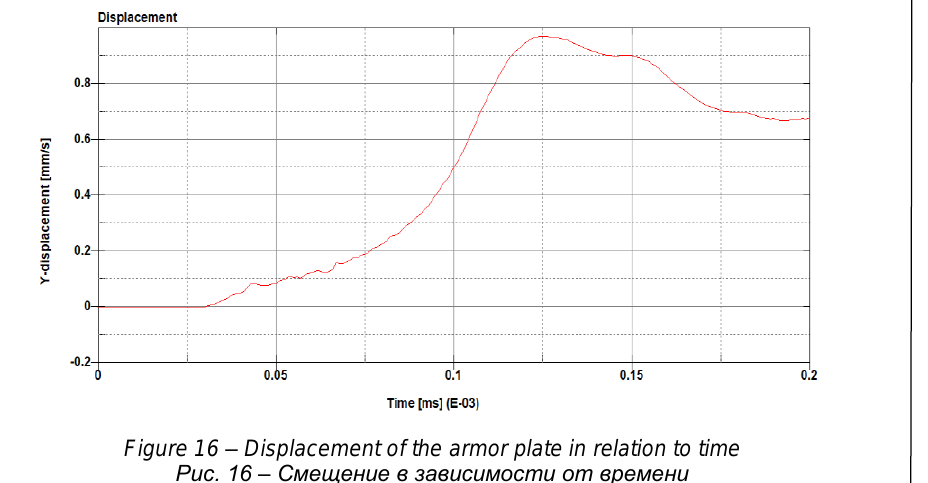
Figure 16 – Displacement of the armor plate in relation to time Рис. 16 – Смещение в зависимости от времени Слика 16 – Померање у зависности од